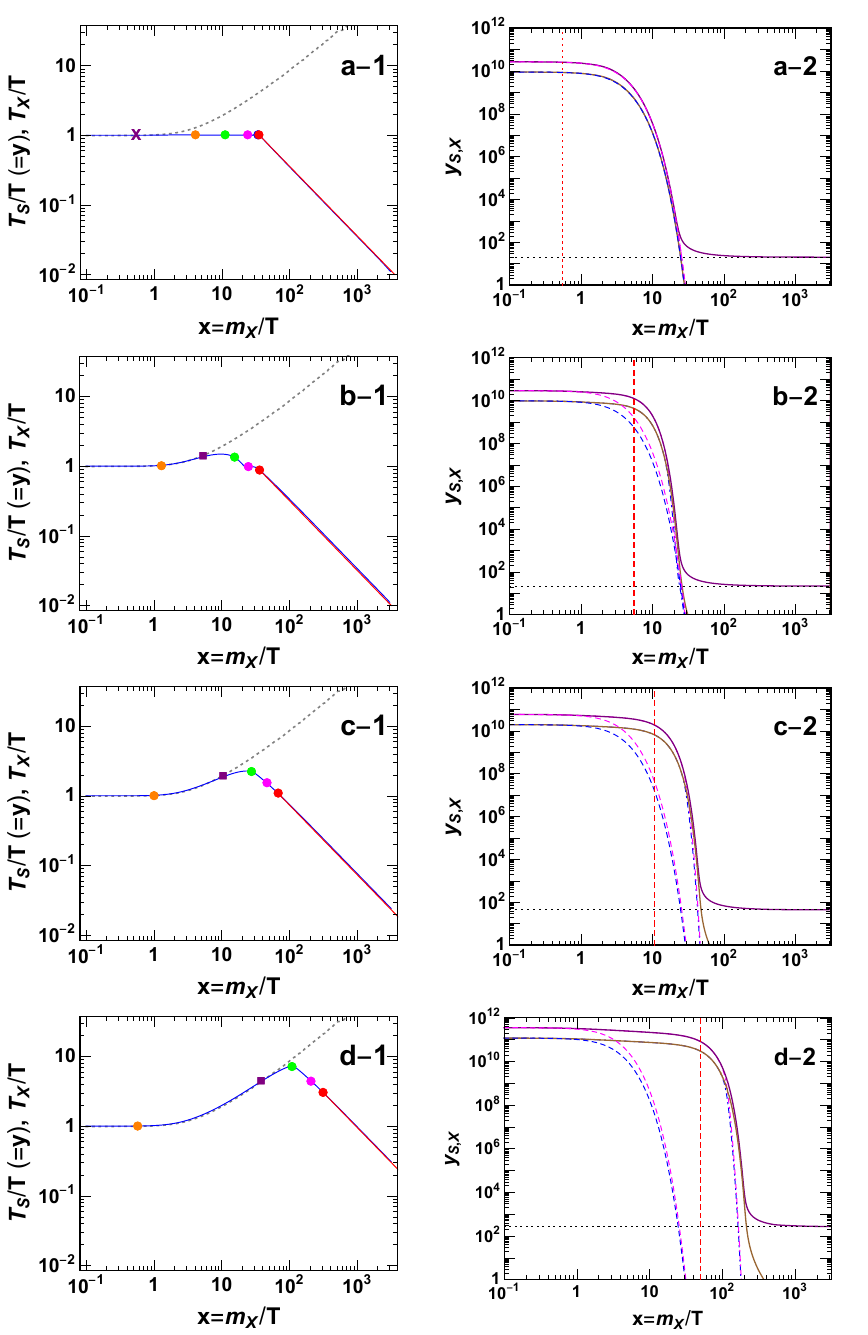
Figure 5 . Same as (cid:12)gure 3, but using m X = 80 GeV and m S = 0 : 99 m X and, in (a), (b), (c), and (d), separately adopting (cid:11) = 1 (cid:2) 10 (cid:0) 5 ; 1 (cid:2) 10 (cid:0) 6 ; 5 (cid:2) 10 (cid:0) 7 , and 1 (cid:2) 10 (cid:0) 7